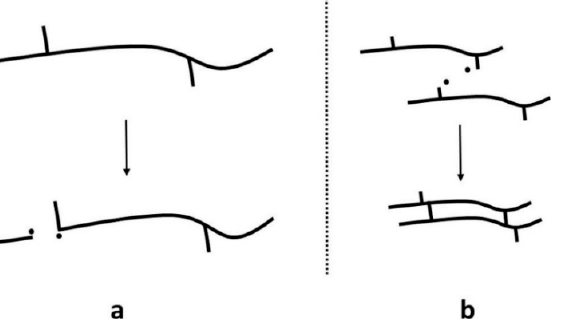
Figure 5. Degradation mechanisms: ( a ) random chain scission and ( b ) crosslinking. Reproduced with permission [18].